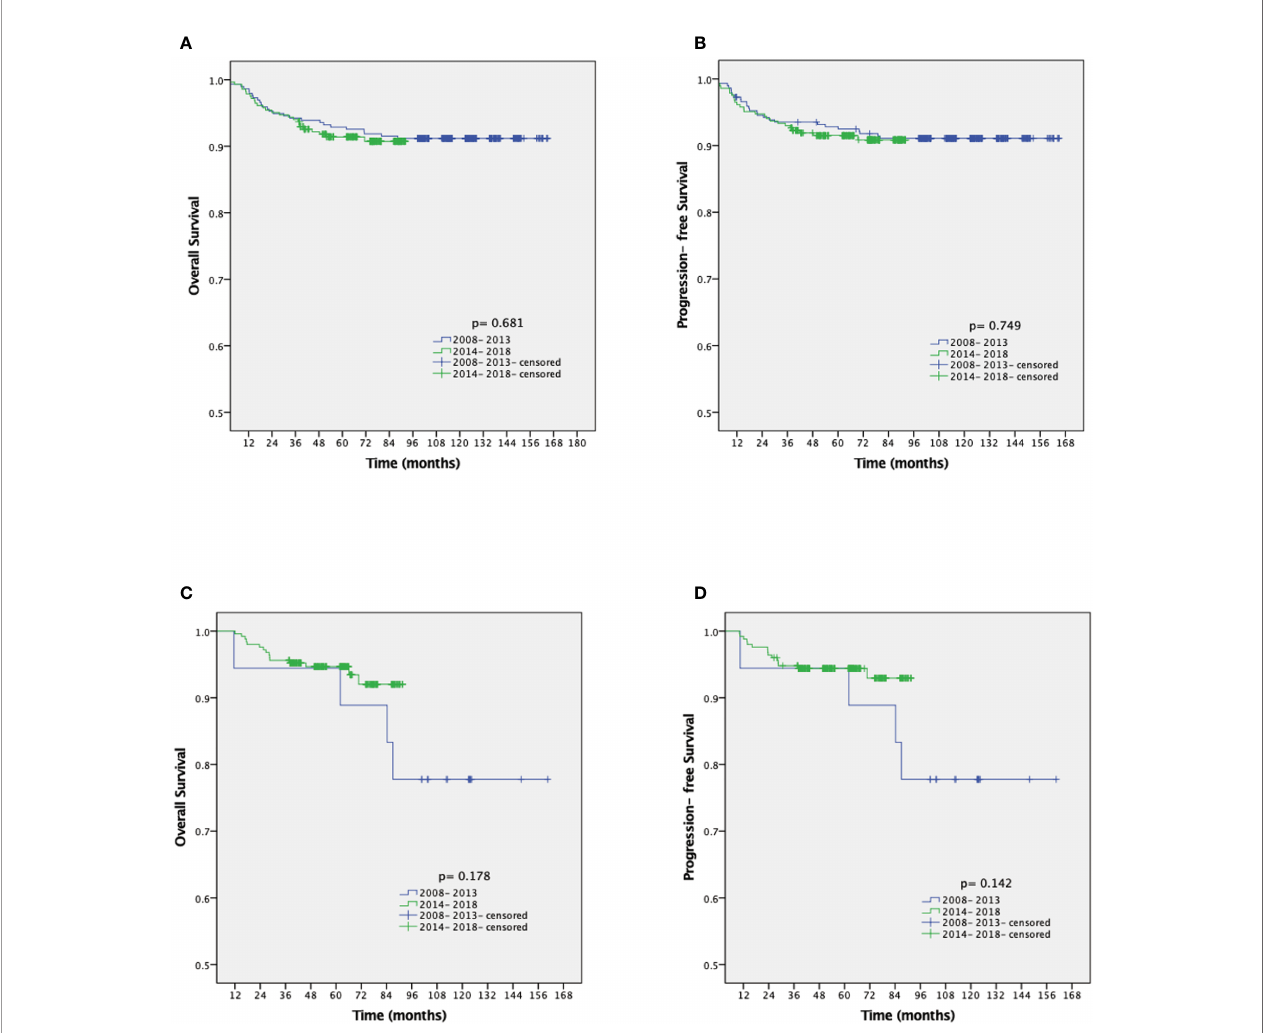
FIGURE 5 | Kaplan-Meier analysis of the OS and PFS for patients with open approach strati fi ed by year of diagnosis (A, B) . Kaplan-Meier analysis of the OS and PFS for patients with MIS approach strati fi ed by year of diagnosis (C, D) . OS, overall survival; PFS, progression-free survival; MIS, minimally invasive